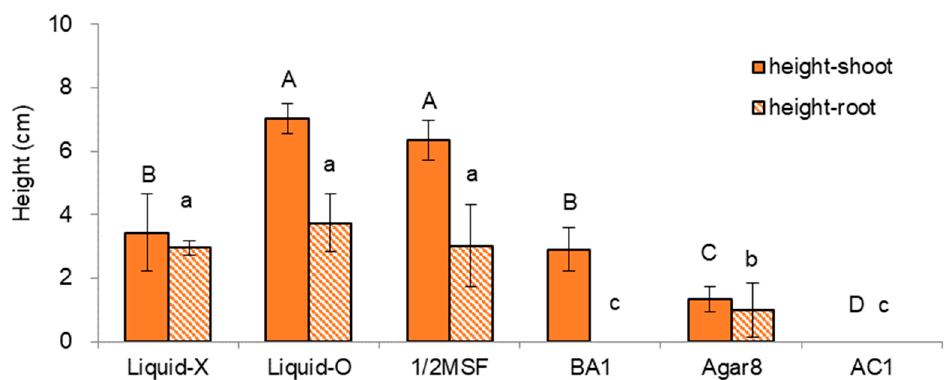
Figure 1. Plant height (cm) of in vitro grown P. yatabeanus plantlets with six treatments of subculture medium and supplements for five weeks. Liquid-X: MSF, gellan gum 3.0 g L − 1 , Liquid-X; Liquid-O: MSF, gellan gum 3.0 g L − 1 , Liquid-O; 1/2MSF: half-strength MSF, gellan gum 3.0 g L − 1 , Liquid-X;